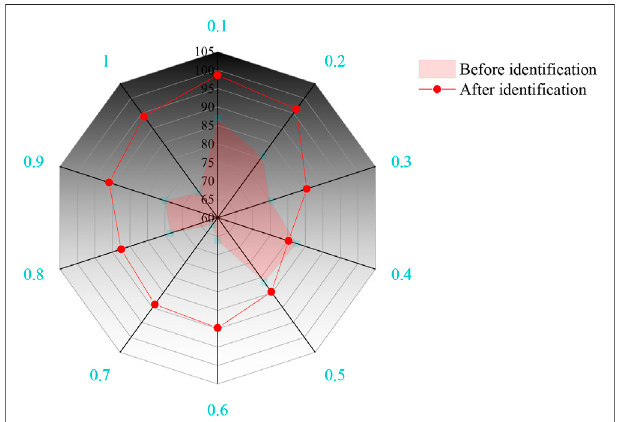
FIGURE 7 | Driving torque con fi dence.